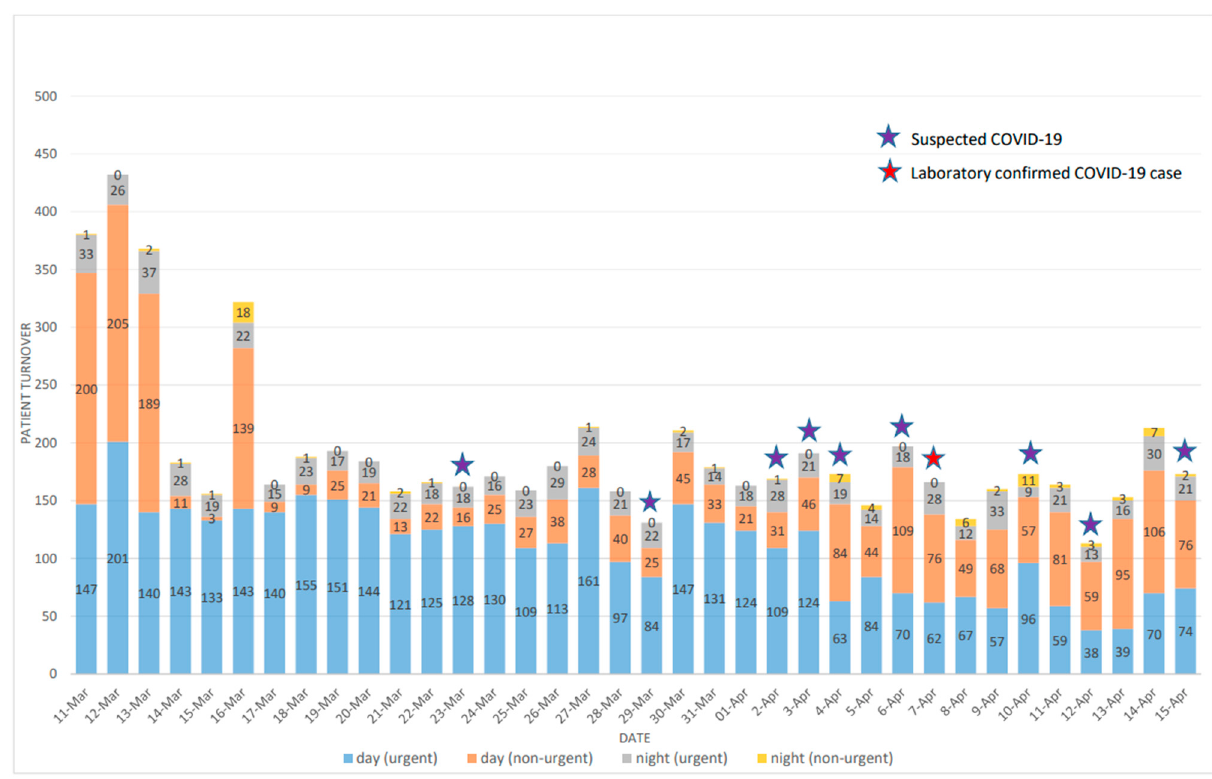
Figure 3. Patient turnover in the Department of Community Dentistry of Semmelweis University, 11 March to 15 April 2020.